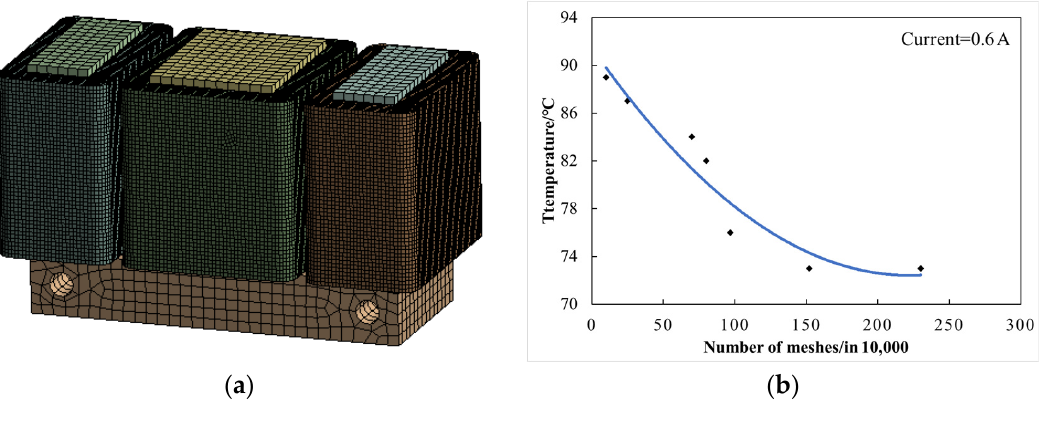
Figure 7. Meshing and verification diagram. ( a ) Electromagnet meshing. ( b ) Meshing independence verification.